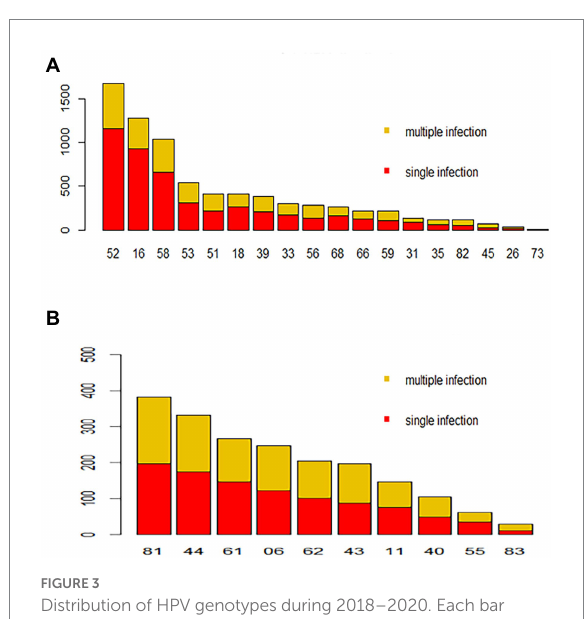
FIGURE 3 Distribution of HPV genotypes during 2018–2020. Each bar represents the number of infections due to corresponding HPV genotypes. Red indicates the number of cases with only single- type infections for the corresponding HPV genotype, and yellow indicates the number of cases due to multiple infections. (A) High-risk HPV infection. (B) Low-risk HPV